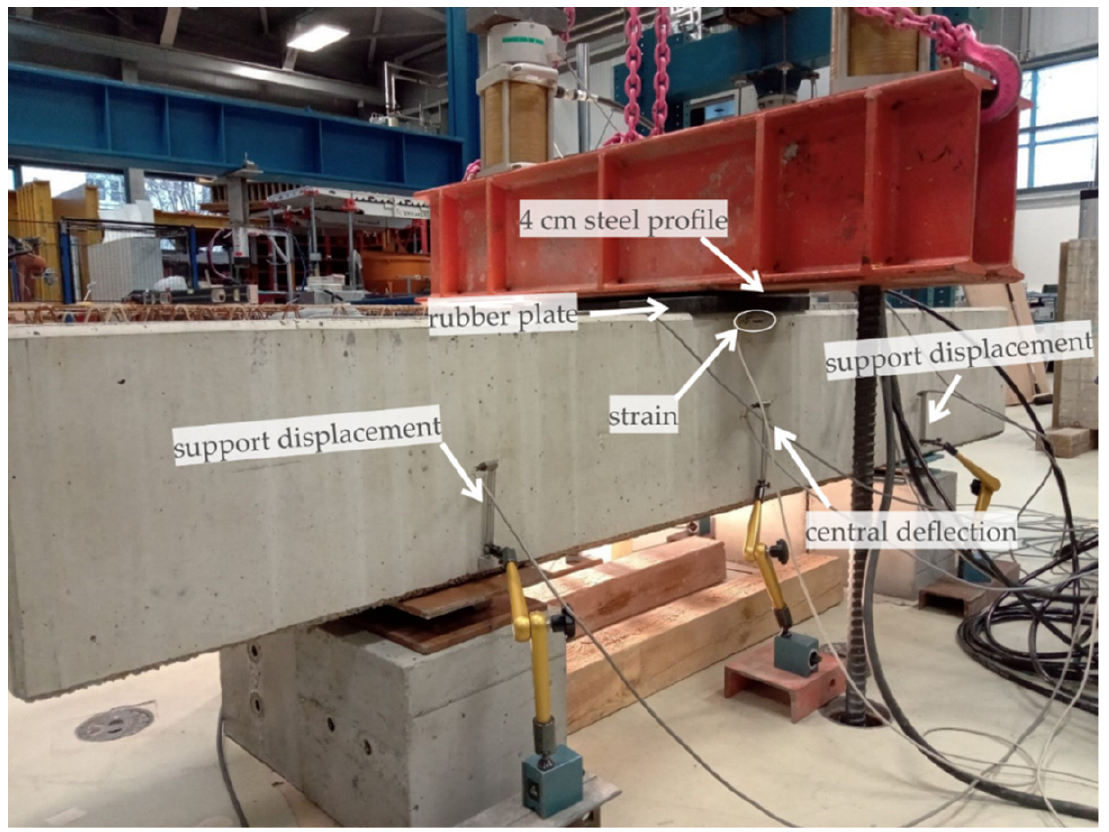
Figure 17. Test setup of the experimental investigations. (Photo: HTWK Leipzig/CARBOCON GMBH).